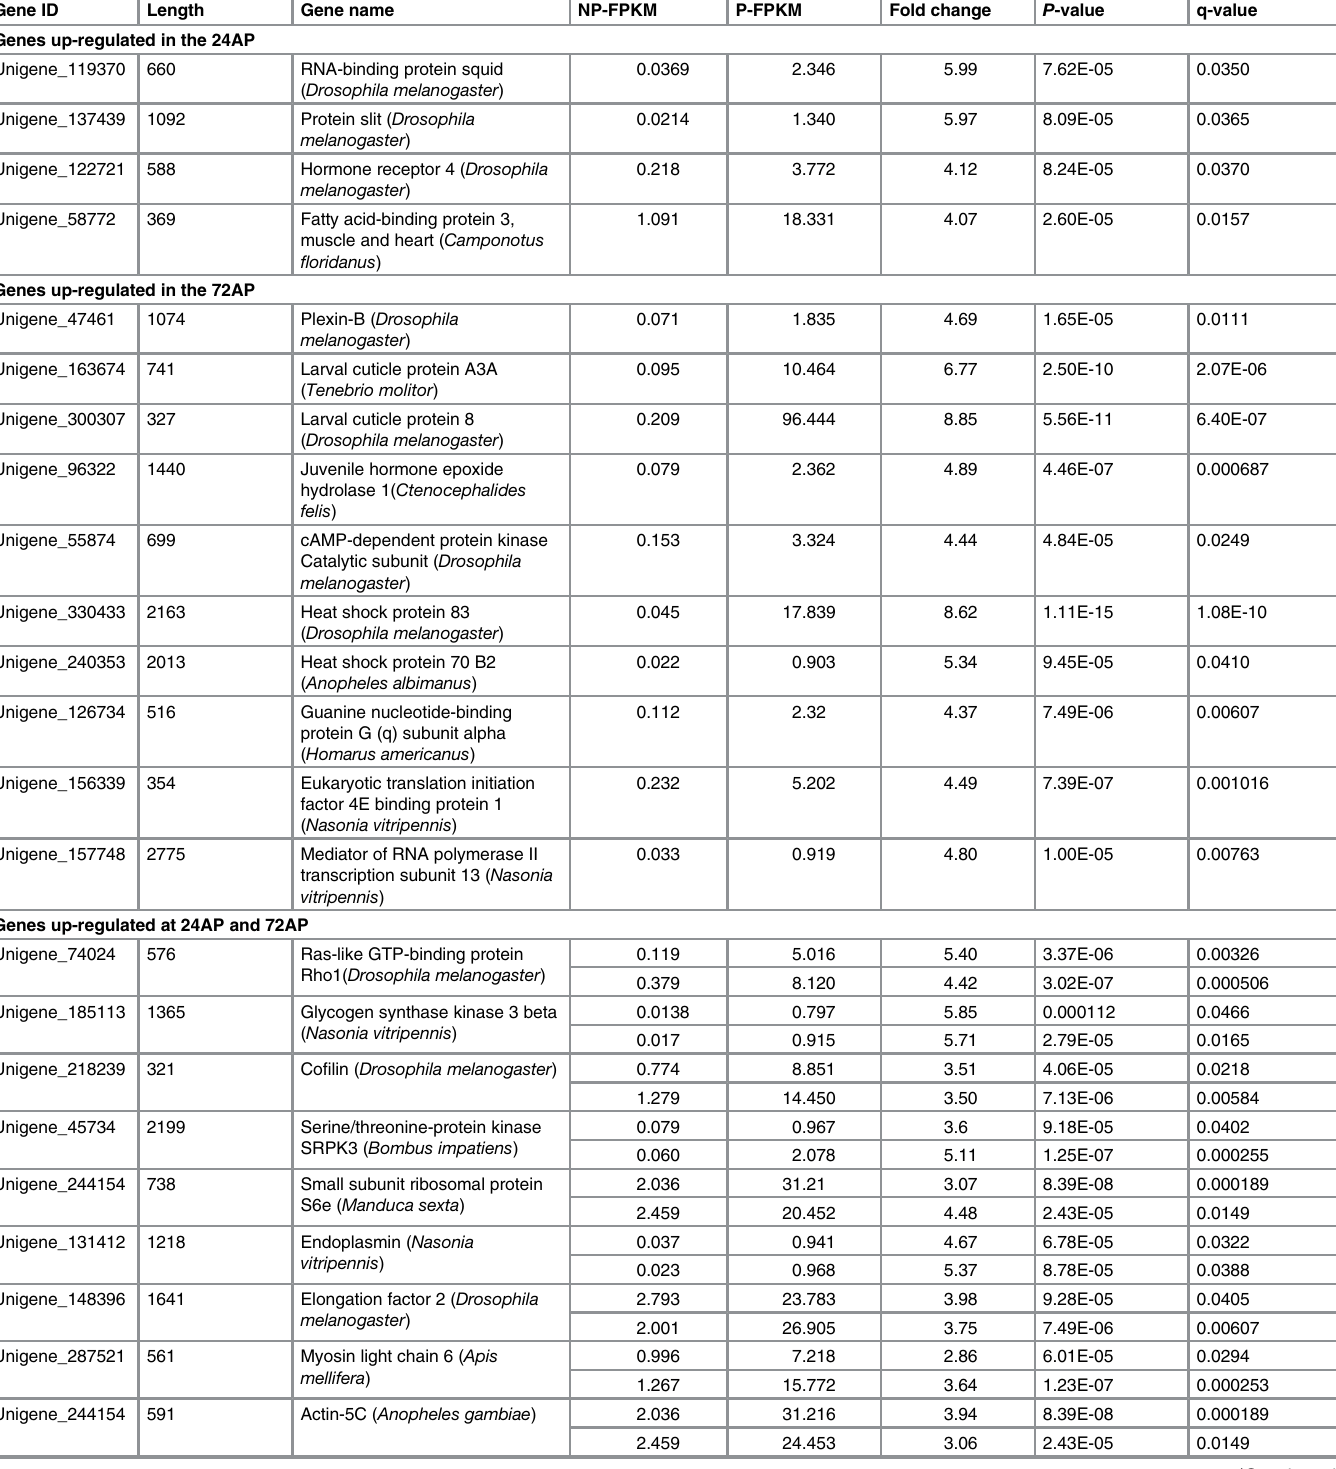
Table 2. Developmental-related genes differentially expressed in B . tabaci after being parasitized by E . sophia . Gene